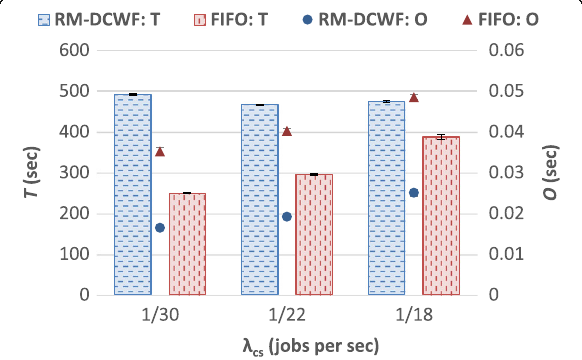
Fig. 17 RM-DCWF vs FIFO: effect of λ cs on T and O when using the CyberShake